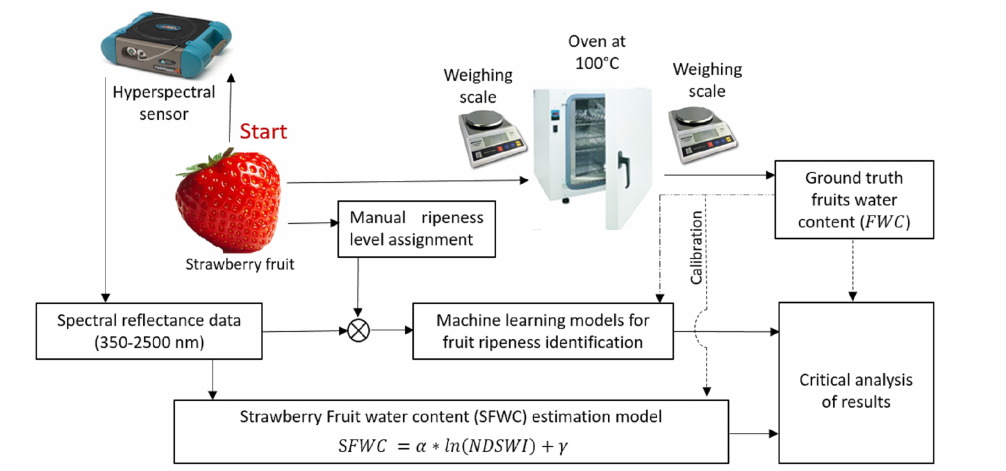
Figure 1. The framework of the strawberry fruit water content estimation and ripeness classification. The strawberry fruit water content estimation and ripeness classification framework. In the SFWC block, α is the gain, γ is the offset, and NSDSWI stands for Normalized Difference Strawberry Water Content